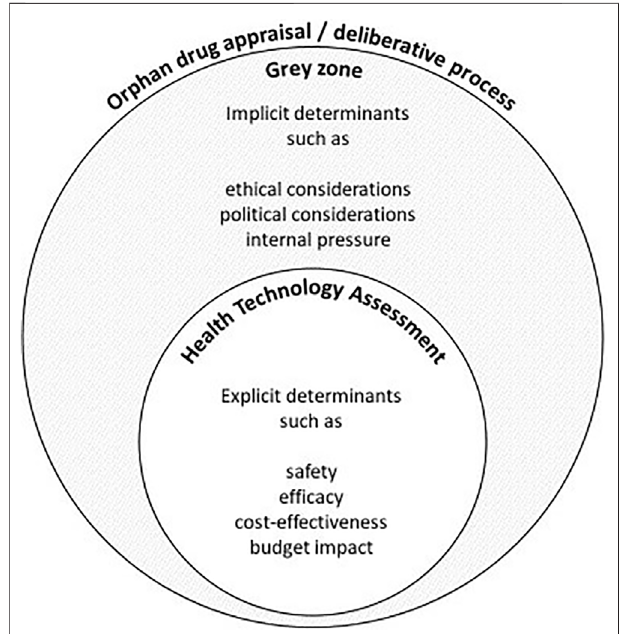
FIGURE 2 | A schematic and nonexhaustive visualization of the deliberative process for the reimbursement of an orphan drug such as nusinersen. Any discrepancy between the assessment and appraisal of an orphan drug may be the result of grey zone determinants that are not adequately described in the fi nal reimbursement